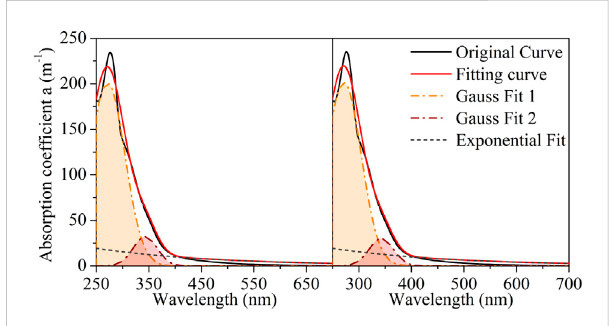
FIGURE 5 Gaussian-exponential combining method fi tting for lignin- dissolved solution (LDS1 and LSD2 denote to the duplicated samples, LDS1 on the left and LDS2 on the right).